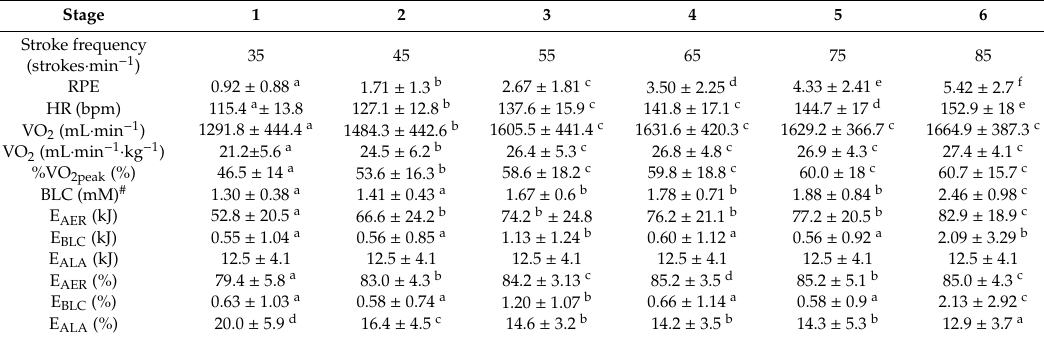
Table 2. Perceived, physiological, and energetic characteristics of forehand loop drive practice (mean ± SD).